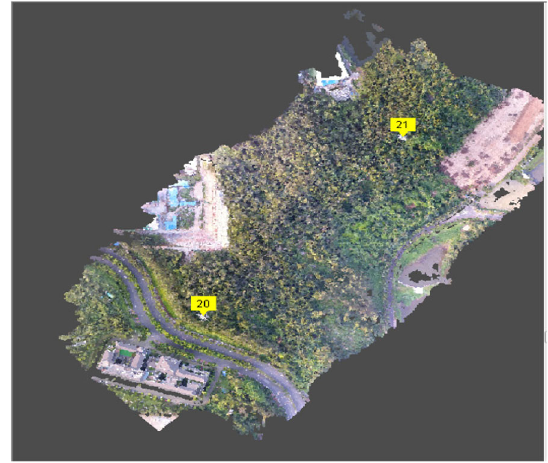
Fig. 4 A photograph with transmission towers. The yellow points represent transmission towers in this tilt photography photo of transmission line with fixed-wing UAV